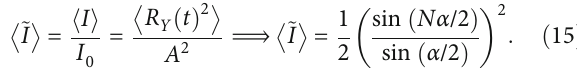
Figure 5: Hyperbolic shaped fringes (yellow dots) distributed on a distant screen (blue line) oriented parallel to the line S when d / λ ∈ ℕ (a) and d / λ ∉ ℕ (b). L is the slit-barrier-screen distance, n is the hyperbolic fringe order, and M Family of hyperbolas with slit sources S 1 and S 2 as common foci (purple) (reproduced from [27] ©IOP Publishing Ltd. CCBY